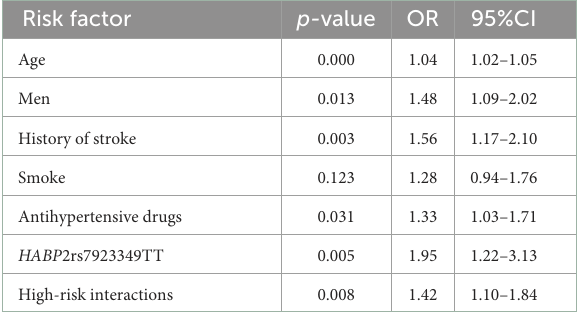
TABLE 5 Multivariate analysis of the major risk factors for carotid stenosis.